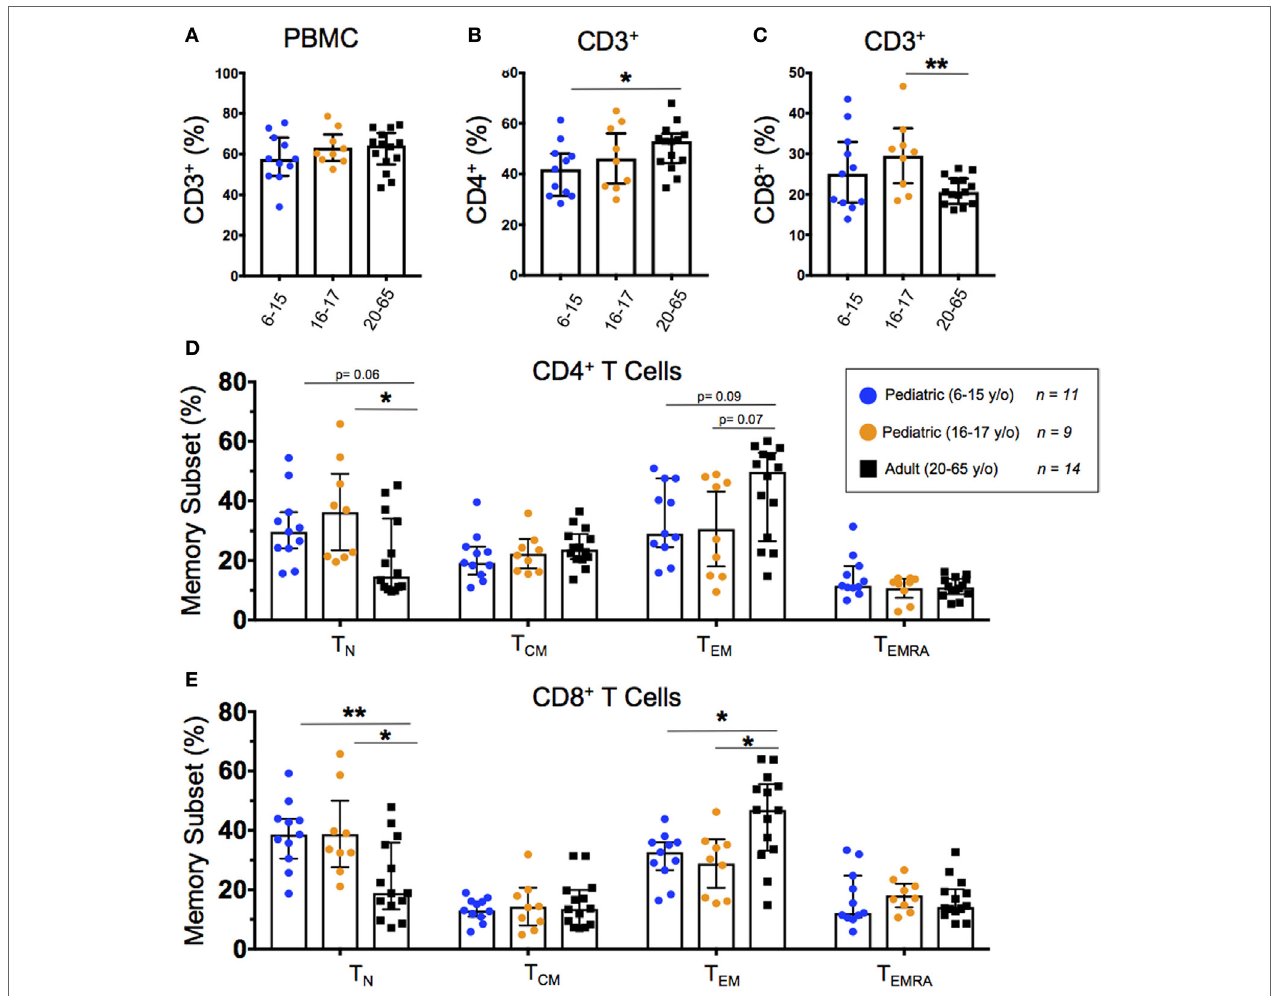
FigUre 1 | Baseline T cell populations. Scatter plots showing the percentages of (a) baseline CD3 + T cells, (B) CD3 + CD4 + helper T cells, and (c) CD3 + CD8 + cytotoxic T cells, as well as (D) CD4 + and (e) CD8 + naive (CD45RA + CD62L + ), T central memory (T CM ; CD45RA − CD62L + ), effector memory (CD45RA − CD62L − ), and EMRA (CD45RA + CD62L − ) populations among 6–15-year-old pediatric ( n = 11), 16–17-year-old pediatric ( n = 9), and adult ( n = 14) participants (media). Bars represent medians with whiskers indicating interquartile ranges. Statistics were analyzed by unpaired t -test (* p < 0.05; ** p <